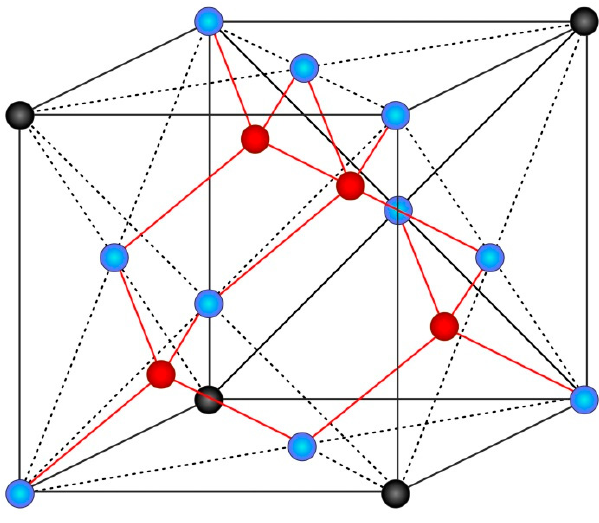
Figure 2. Tetrahedral structure of a diamond.